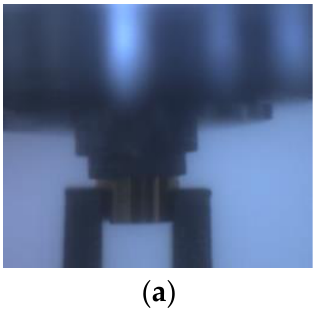
assembly; ( b ) Left view of the TMP-Component after assembly. ( b ) Left view of the TMP-Component after